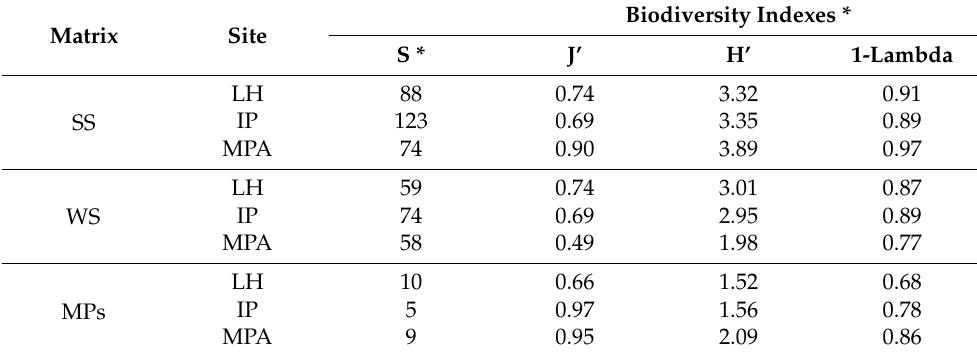
Table 1. Biodiversity indexes of sampling sites from different